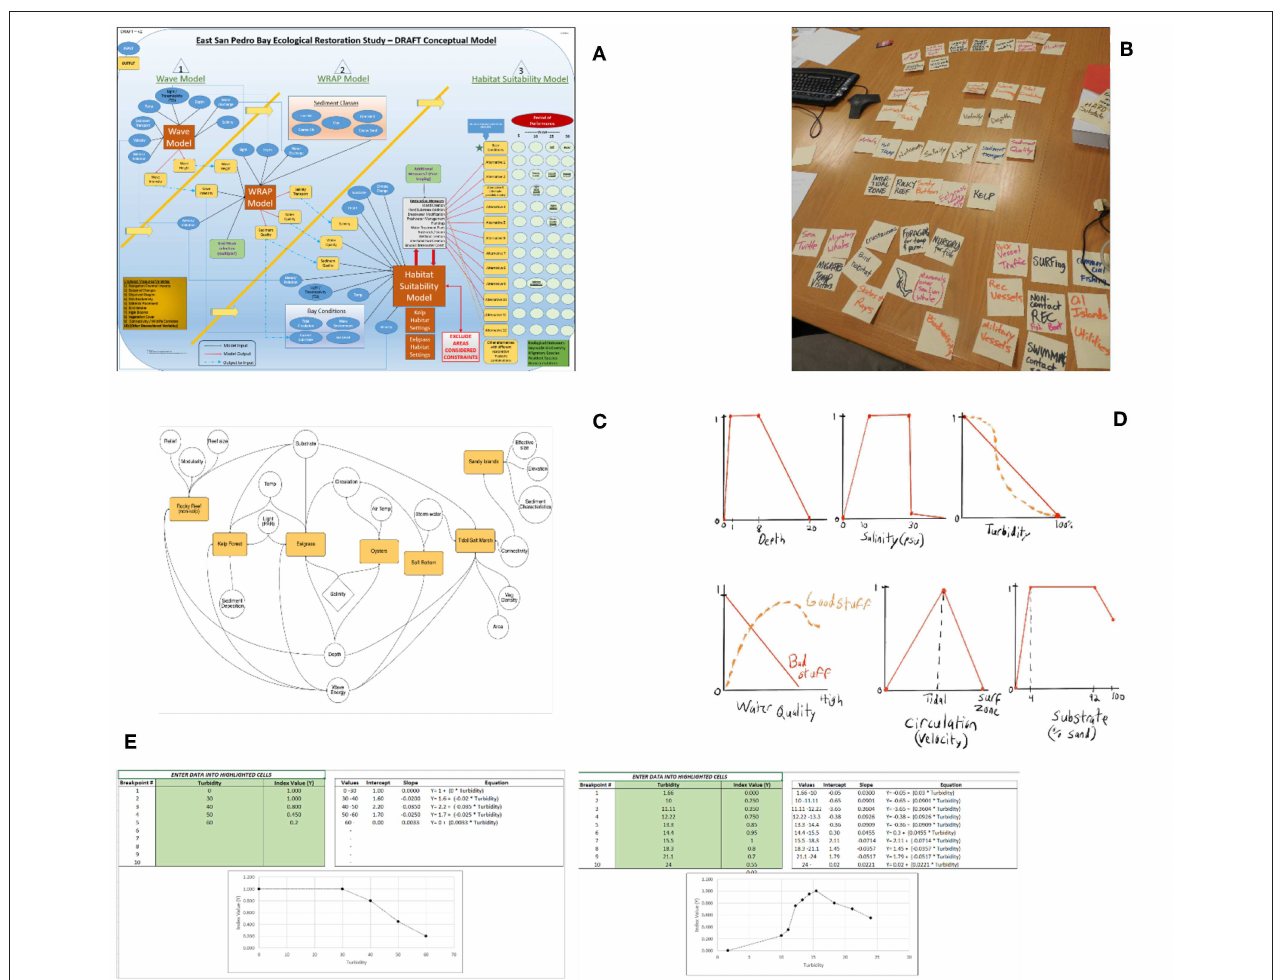
FIGURE 1 | Typical outcomes from multiple mediated modeling workshops include preliminary conceptual models, which serve as a basis for intellectual organization and provide a foundation for numerical model development. This figure shows conceptual models iteratively developed at a series of mediated modeling workshops for East San Pedro Bay. (A) A preliminary conceptual model was developed by the technical team prior to the workshop, but the complexity overwhelmed project partners. (B) The workshop team constructed a model using scraps of paper. (C) The scrap-paper model was translated into a preliminary “lumped” model for rapid communication. (D) Qualitative response curves were developed on a whiteboard to guide numerical model development [example using seagrass habitat]. (E) Subset of variable quantification seagrass habitat using a rapid development, index-based modeling